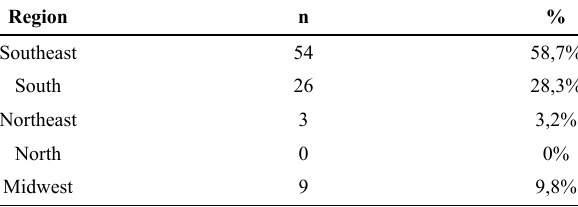
Table 3 - Brazilian region of origin.